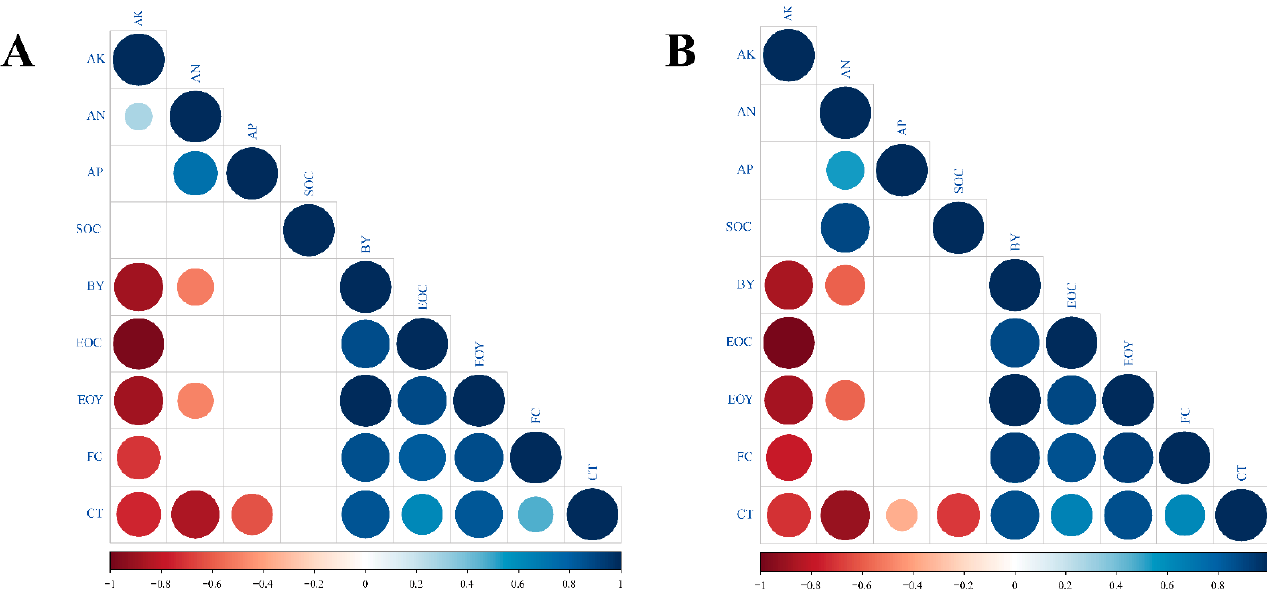
Figure 1. Correlations among soil organic matter, available N, P, and K, and biomass yield, ferulic acid content, essential oil content, essential oil yield: ( A ) in 2018; ( B ) in 2019 (Note: The criterion for statistical significance was set at p < 0.05; spaces indicate no correlation or insignificant correlation; AK represents available K; AN represents available K; AP represents available K; SOC represents soil organic carbon; BY represents biomass yield of A. sinensis ; EOC represents essential oil content of A. sinensis ; EOY represents essential oil yield of A. sinensis ; FC represents ferulic acid content of A. sinensis ; CT represents chloroplast content of A. sinensis. ).